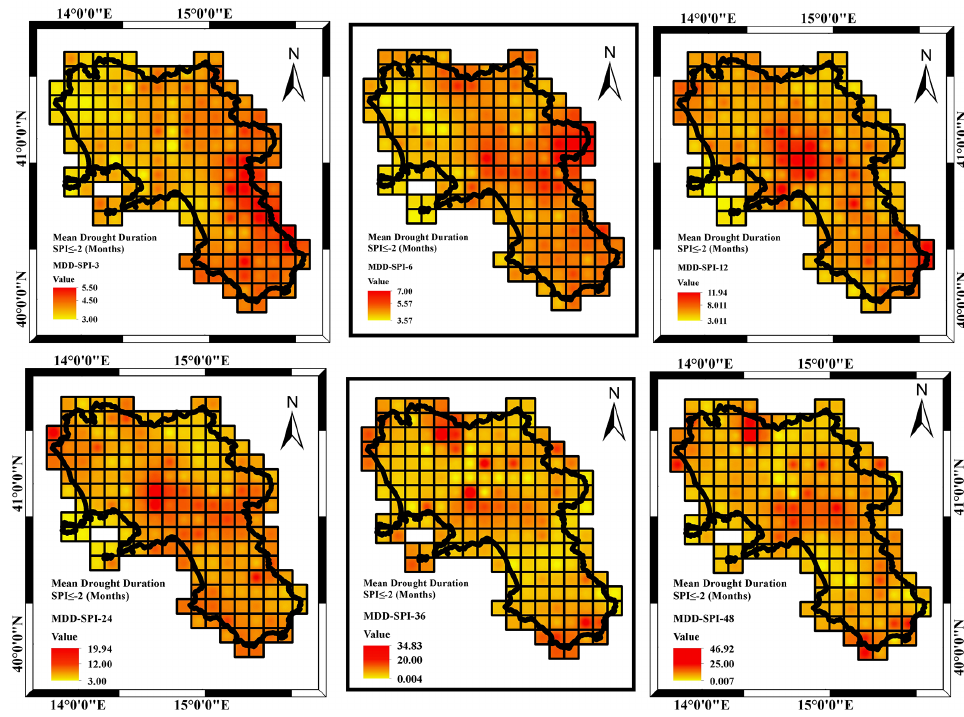
Figure 11. MDD (mean drought duration) for the different accumulation periods considered (SPI ≤ −